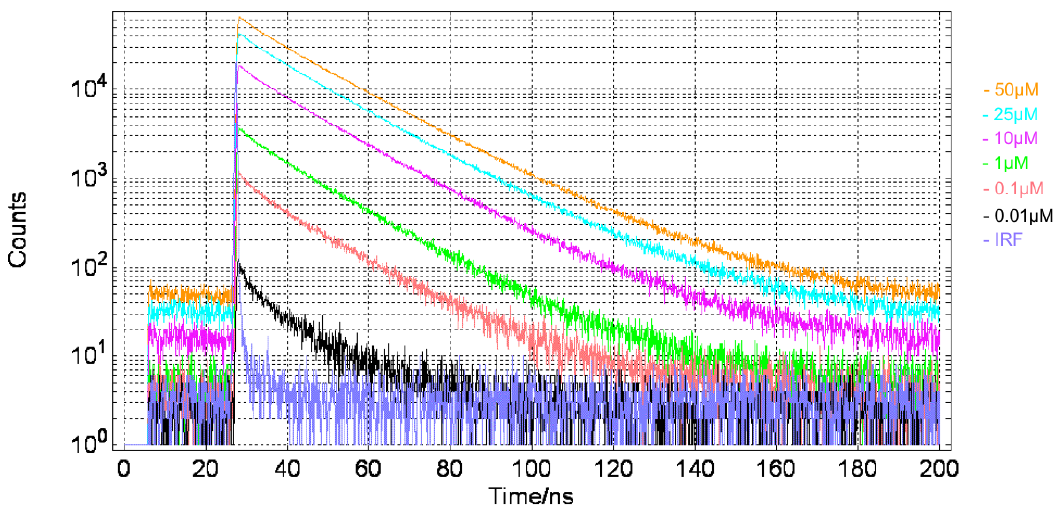
Figure 13. Time resolved decay curves of quantum dot sample, evaluated at different concentrations. Measurement made using external TCSPC